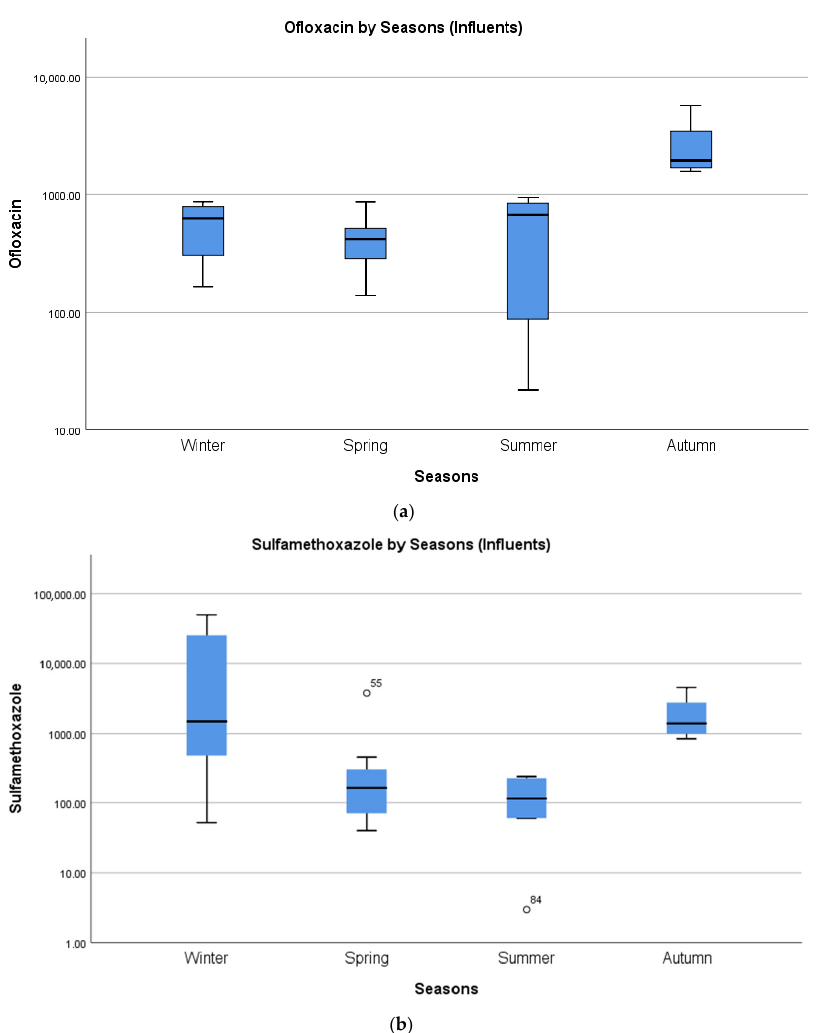
Figure 5. Seasonal differences in ofloxacin ( a ) and sulfamethoxazole ( b ) concentrations in influent WW (values in ng/L are reported on a log10 scale). Results of one-way ANOVA are illustrated in the supplementary material (Tables S4–S7). Seasonal variations were also investigated in the effluents of WWTPs. In this case, significant differences in effluent concentrations across seasons were observed for azithro- mycin and ciprofloxacin. The azithromycin concentration was significantly higher during winter than in summer ( p -value: 0.019). Inversely the pattern observed for ciprofloxacin was higher in spring than winter ( p -value: 0.005), summer ( p -value: 0.001) or autumn ( p - value: 0.009) (Figure 6).